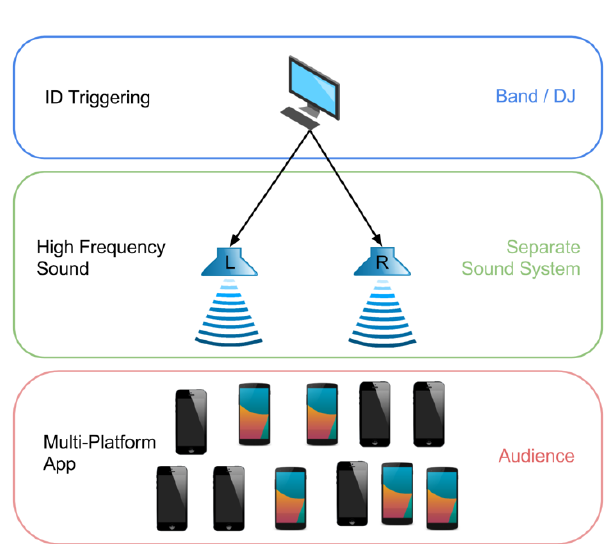
Figure 1. The technical setup of using high- frequency sound